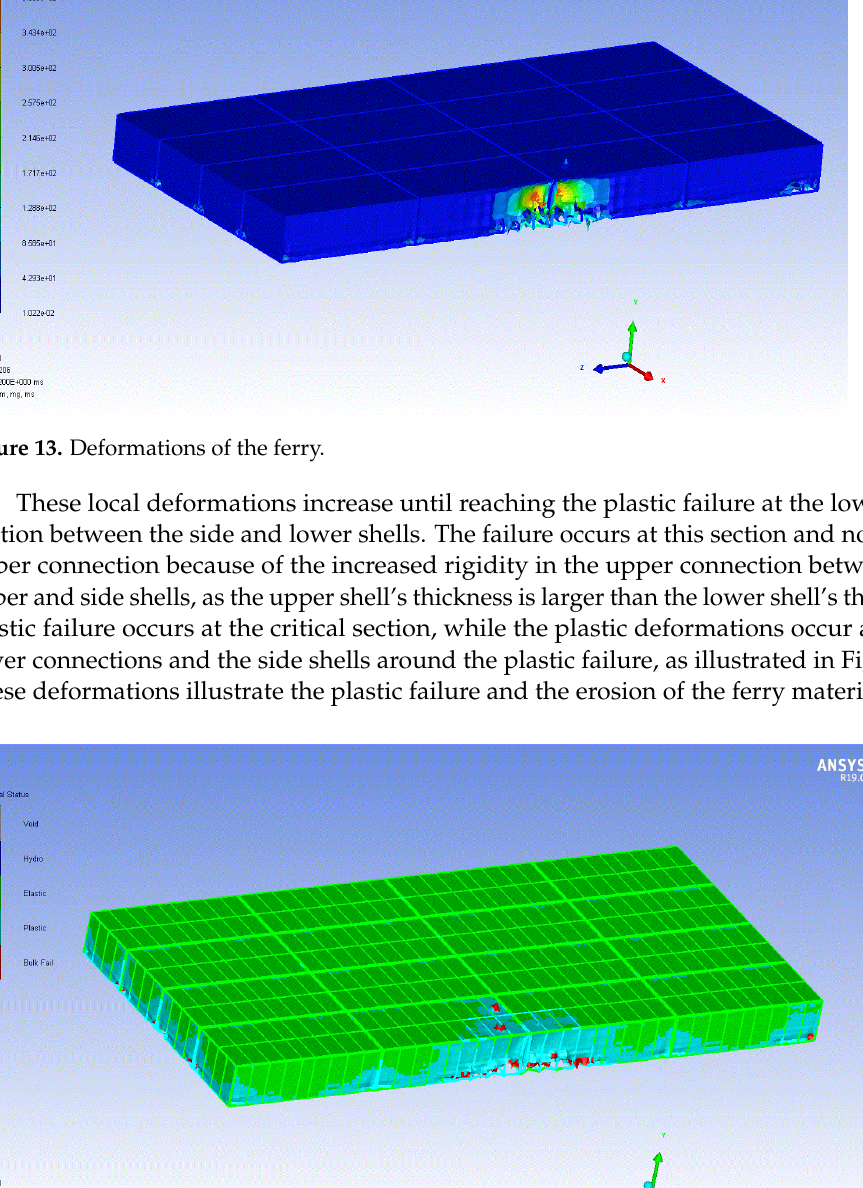
Figure 12. Displacement of the ferry from a side explosion of 5 kg TNT.